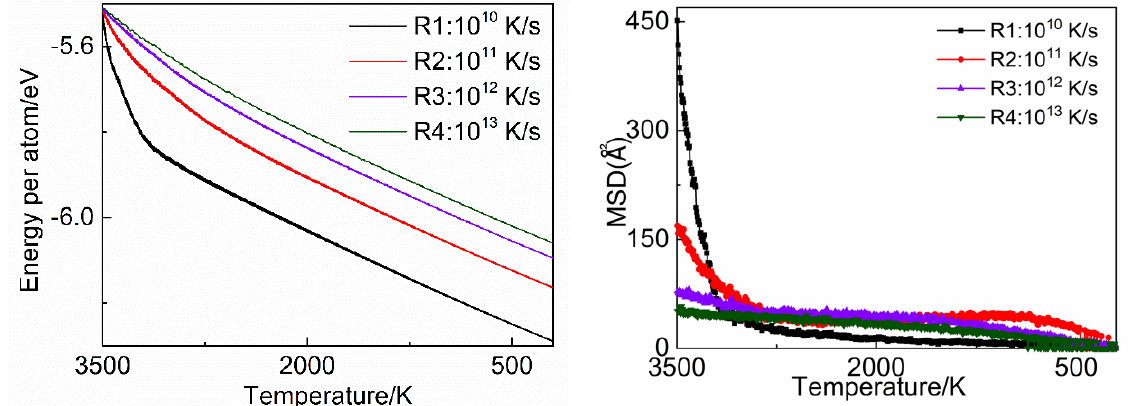
Figure 5. Variation in the average potential energy per atom as a function of temperature for different cooling rates. ( left ) MSD of four different cooling rates. ( right ).